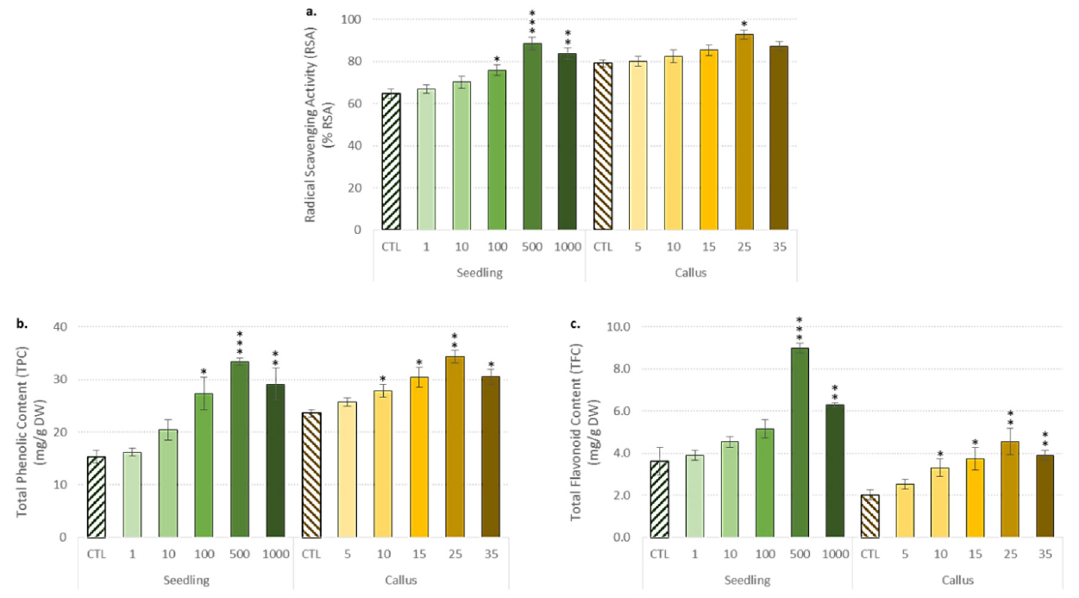
Figure 4. Influence of the different concentrations of ZnONPs on non-enzymatic antioxidant response in the seedlings and the stem-derived callus of L. usitatissimum. ( a ) The free radical scavenging activity (FRSA); ( b ) the total phenolic content (TPC); and ( c ) the total flavonoid content (TFC). Values are